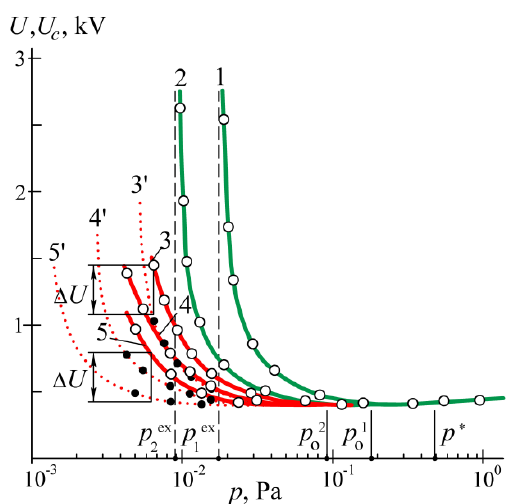
Figure 2. Discharge voltage U (solid lines) and cathode fall U c (dotted lines) versus argon pressure p at a current of I = 1 A and the anode surface area S a ≈ 320 (1), 160 (2), 80 (3), 40 (4) and 20 (5) cm 2 . At S a ≈ 320 and 160 cm 2 , U c = U. At p = p o , U starts to rise with the pressure decrease. At p = p ex , the discharge extinguishes.